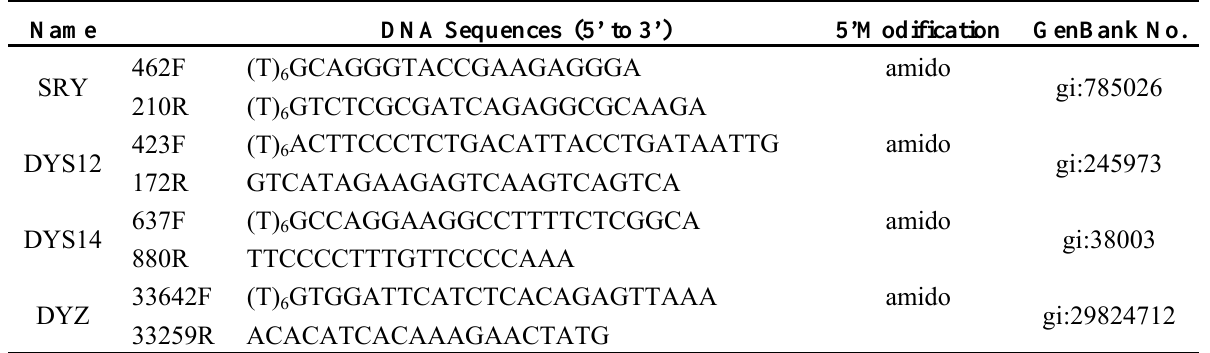
Table 1. DNA sequences of the primers used in this study.